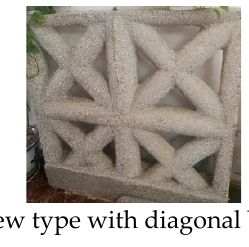
Figure 1. Schematic diagram of EPSC.